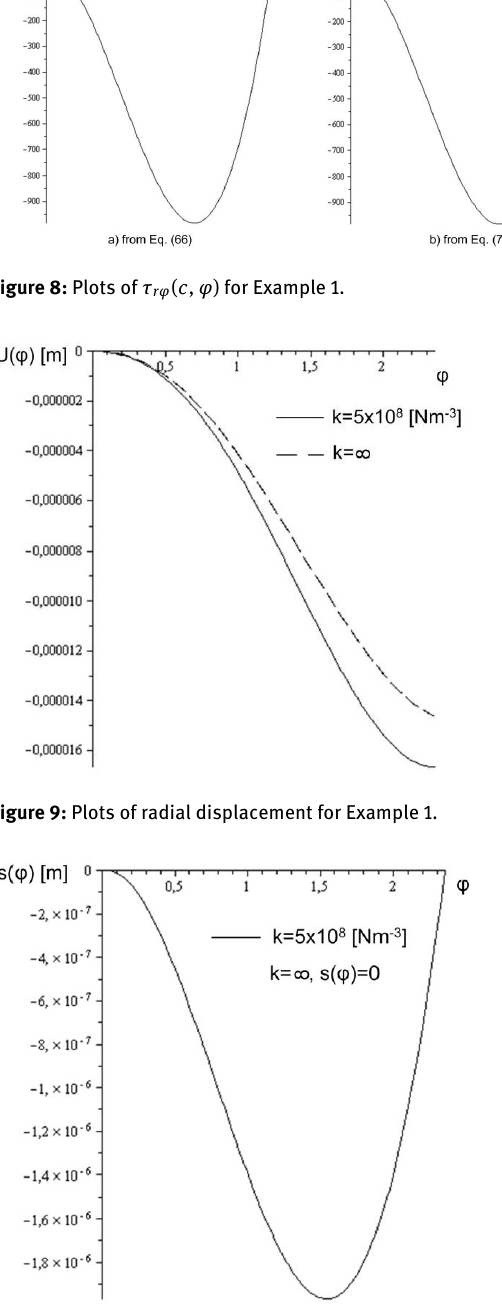
Figure 10: Plots of the slip function for Example 1.